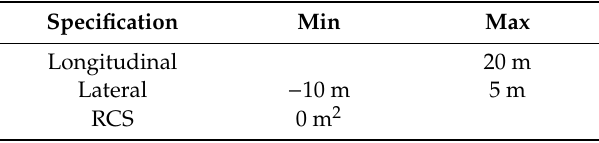
Table 5. Filter setup for Figure 10 with min and max